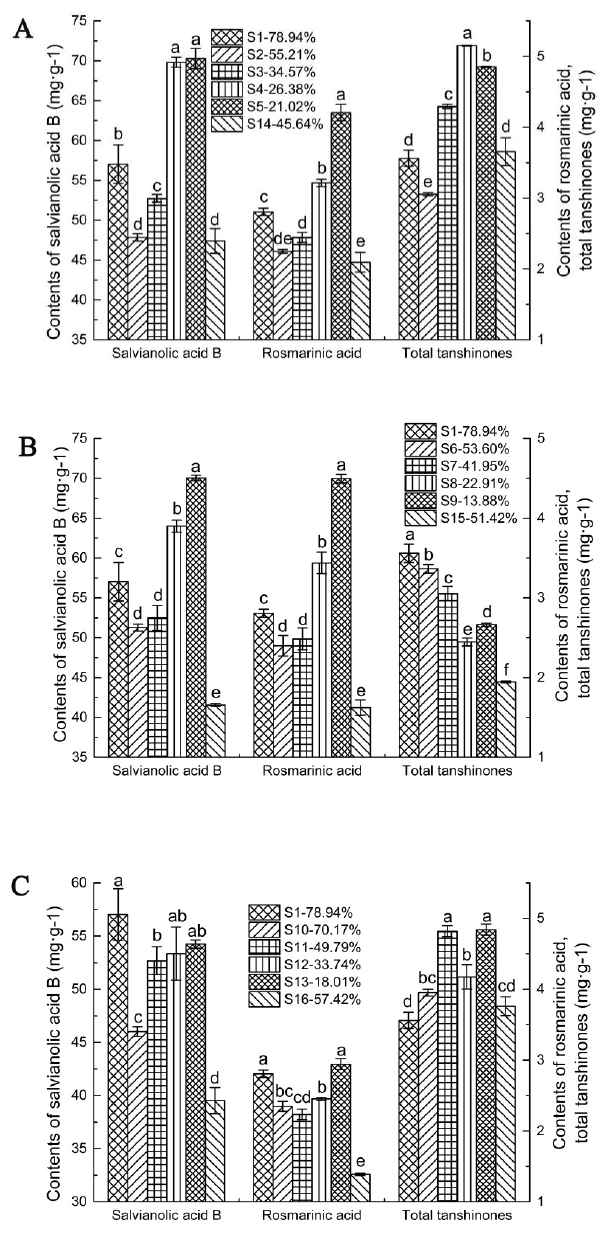
Figure 3. Changes in S. miltiorrhiza ingredient contents under different processing methods. ( A ) Shade drying; ( B ) sun drying; ( C ) oven drying. Note: Figures ( A ), ( B ) and ( C ) were compared with the corresponding S14, S15 and S16 respectively, p < 0.05.